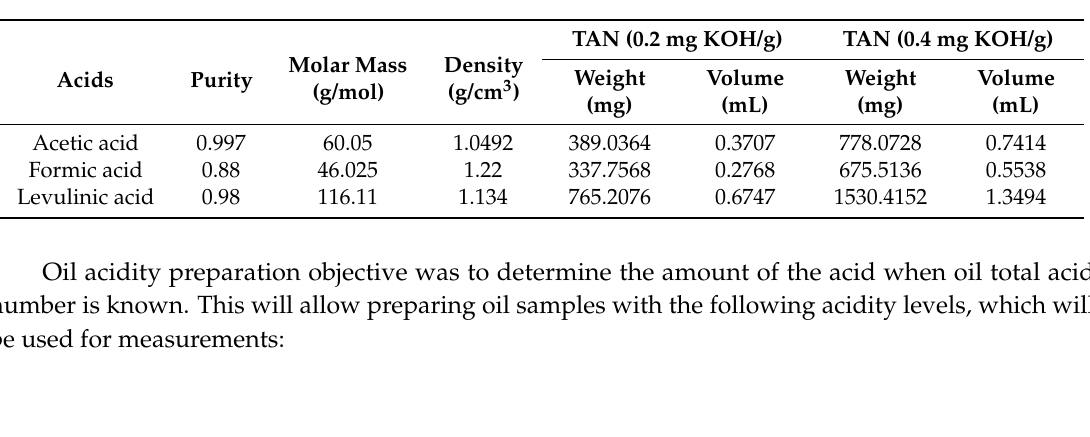
Table 1. Summary of acids masses to be added in 2000 mL